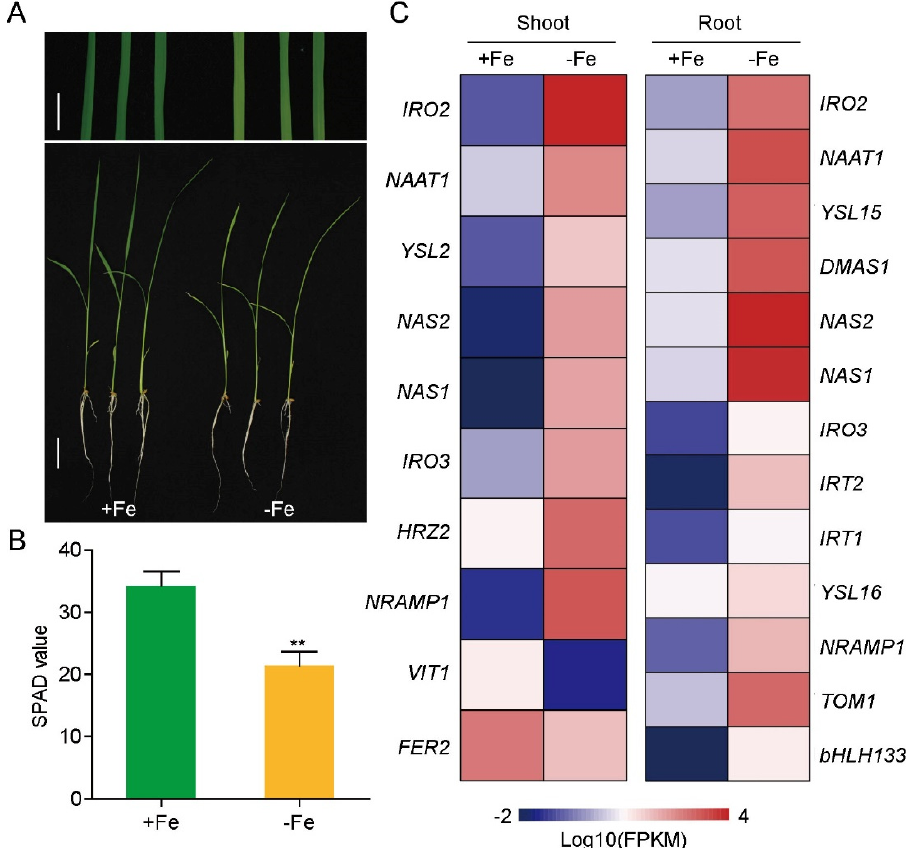
Figure 1. Physiological responses of rice seedlings to iron deficiency and expression pattern of Fe-related marker genes in RNA-seq. ( A ) Phenotypes of Nipponbare grown with 125 μ M EDTA-Fe (II) (+Fe) or no Fe (-Fe) for 10 days (upper bar represents 1 cm, lower bar represents 3 cm). ( B ) Soil Plant Analysis Development ( SPAD ) values representing chlorophyll content of leaves. Data represent means ± SD, n = 4; ** p < 0.01, one-way ANOVA followed by the Tukey test. ( C ) Heatmap of Fe-related marker genes in rice shoot and root under iron deficiency.